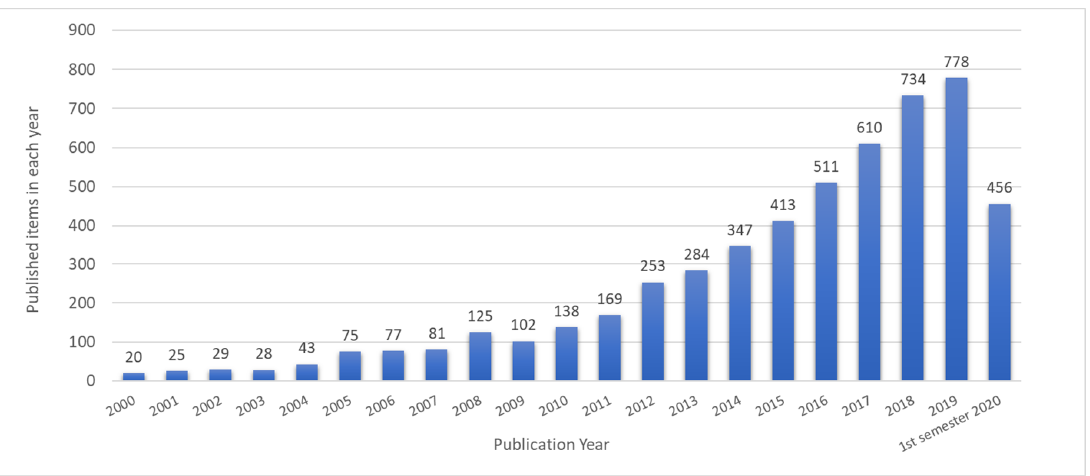
Figure 1. Number of publications concerning model predictive control applications in greenhouse climate control field (Source: Scholar Google).